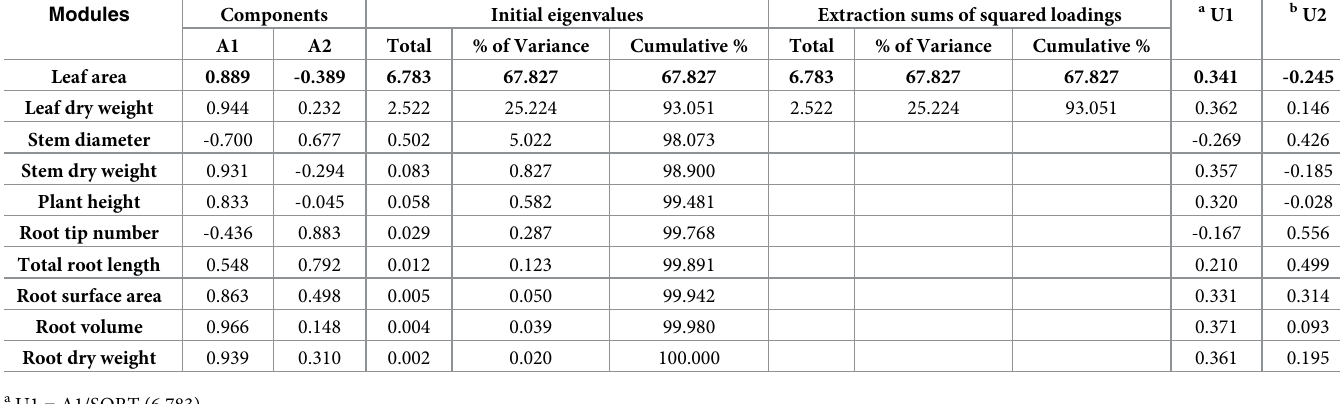
Table 3. Total variance interpretation and component matrix of population modules in soybean/wheat sole cropping and intercropping populations at different nutrient levels and planting densities. Modules